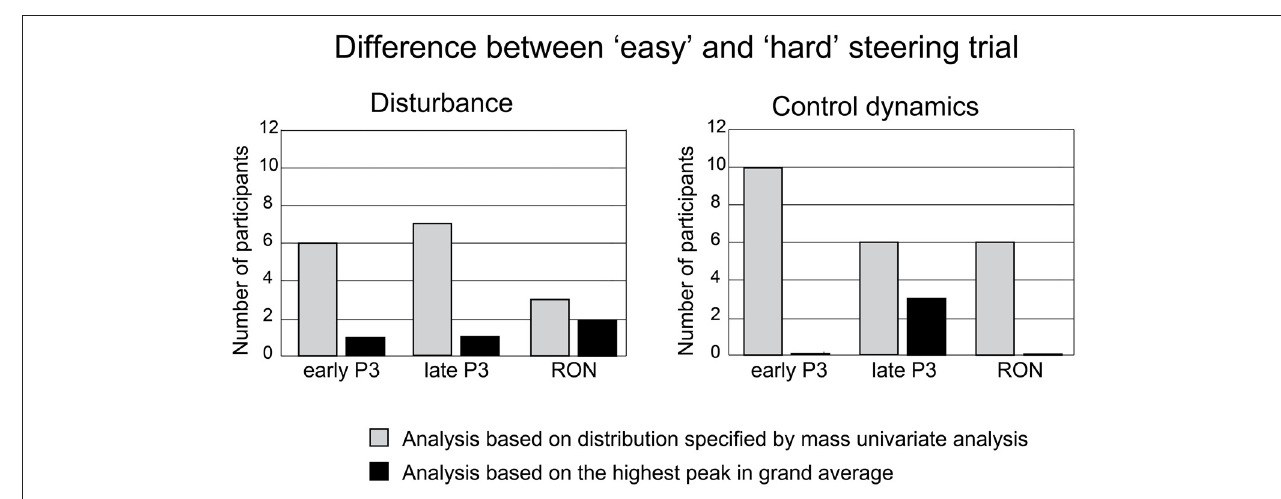
FIGURE 7 | Permutation tests were performed to evaluate steering manipulations of the disturbance (left) and control dynamics (right). Bar plots indicate the number of participants that exhibit a significant difference in their early P3, late P3 and RON between the “easy” and “hard” conditions. Light gray bars indicate participants who showed a reliable difference between the “easy” and “hard” conditions when the analysis was based on the electrodes and time points indicated by mass univariate analysis. Black bars indicate participants who showed a reliable difference between the “easy” and “hard” conditions when the analysis was based on the peak in the grand averaged